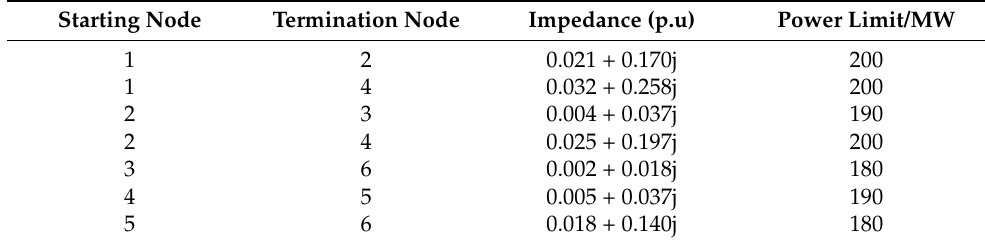
Table 2. Transmission network parameters.